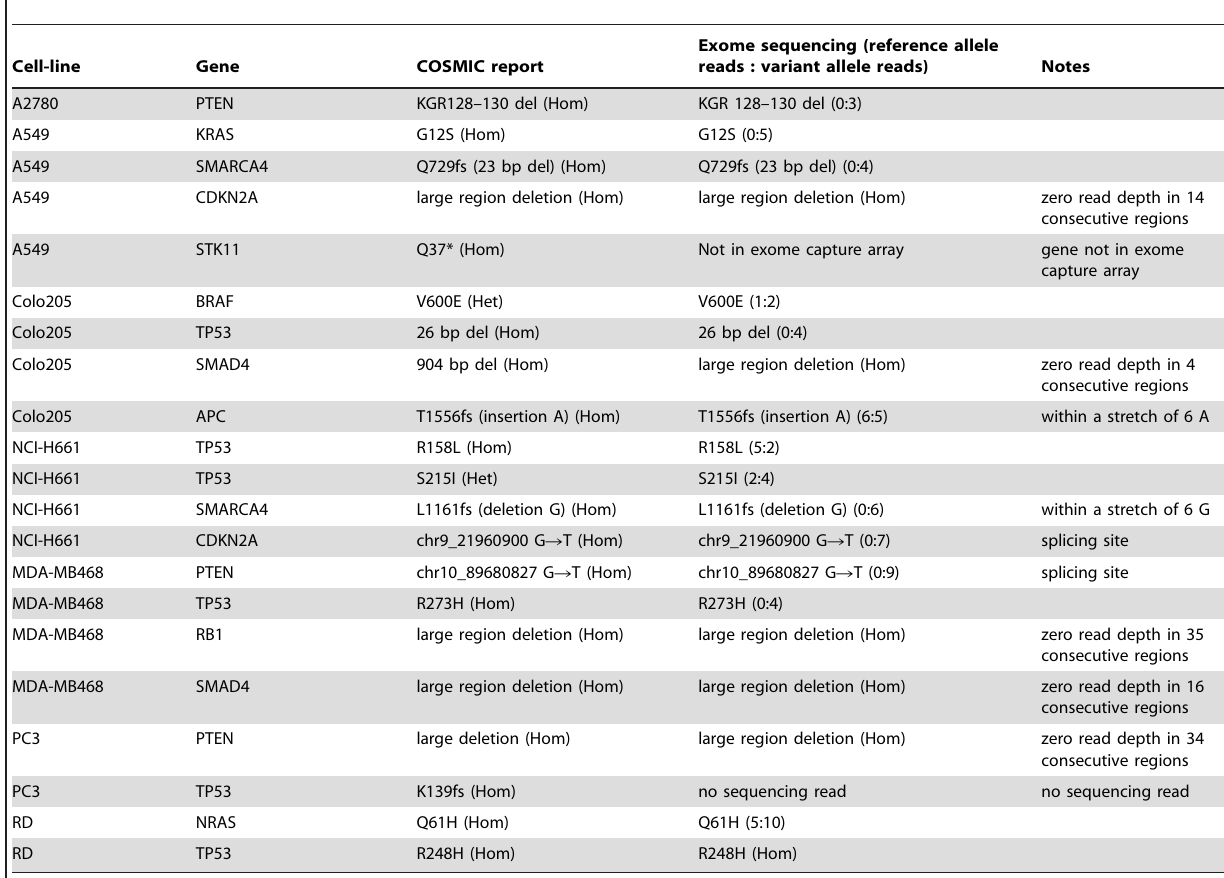
Table 3. Comparison of exome sequencing results with mutations reported in the COSMIC database.